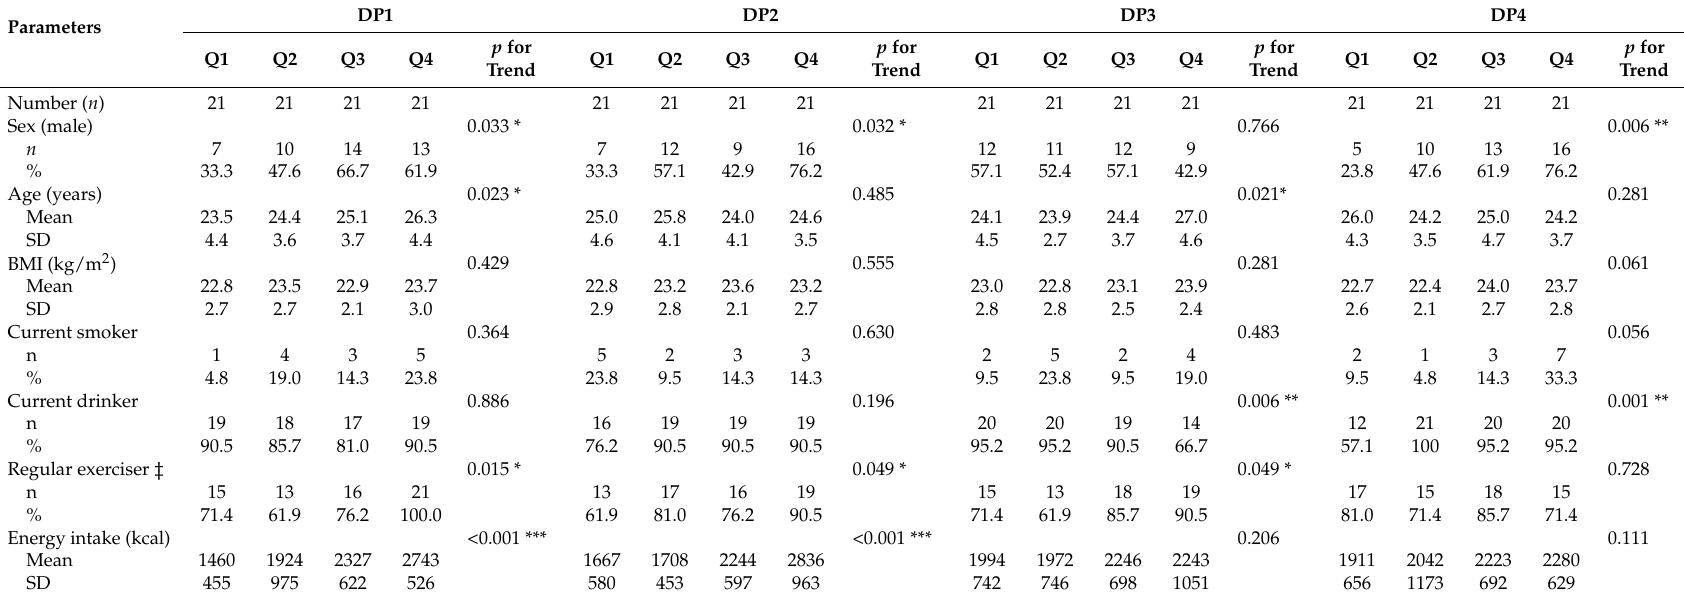
Table 2. General characteristics across the quartiles of dietary pattern scores